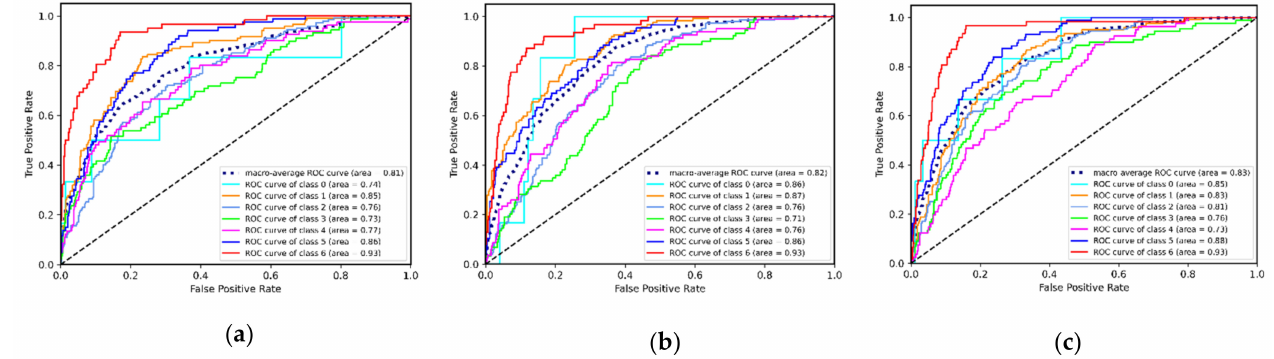
Figure 4. ROC curves of three models on the test results of TCI. ( a ) LeNet-5. ( b ) AlexNet. ( c ) VGG-16s. True Positive Rate (TPR): the percentage of actual positives that are accurately identified; False Positive Rate (FPR): the percentage of actual negatives that are incorrectly identified as positives. Higher TPR and lower FPR indicate better performance. The area under the ROC curve is also a measure of test results, where a greater area means better